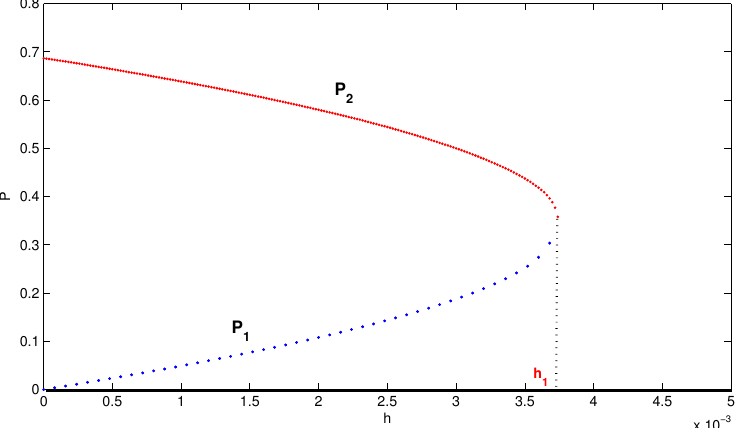
Figure 2. The backward bifurcation diagram of P 1 and P 2 versus h for Equation (3). The solid line with P 1 and dotted line with P 2 represent the curves of the predator with coexistent equilibrium E 1 and E 2 , respectively.